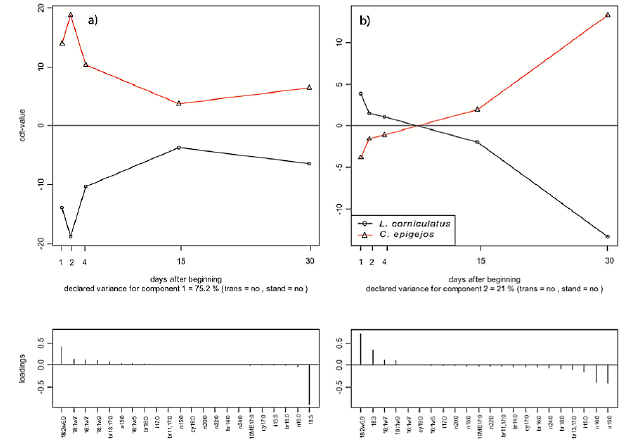
Fig. 5. First (a) and second (b) component of the PRC calculation on the basis of the percentage distribution of litter 13 C within the PLFA composition in C. epigejos and L. corniculatus throughout the experimental period of 30weeks ( n =